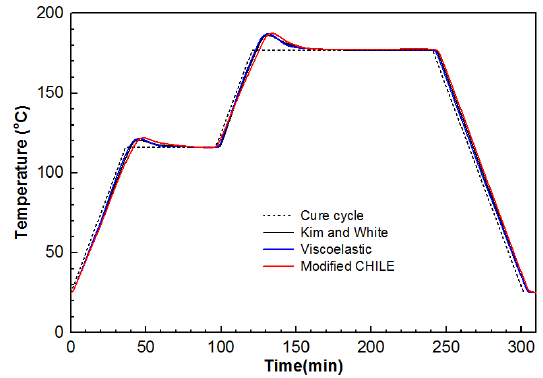
Figure 4. Temperature development in central point (5.08, 5.08, 1.27) of the composite laminate under from the modified cure hardening instantaneously linear elastic (CHILE) and viscoelastic models.